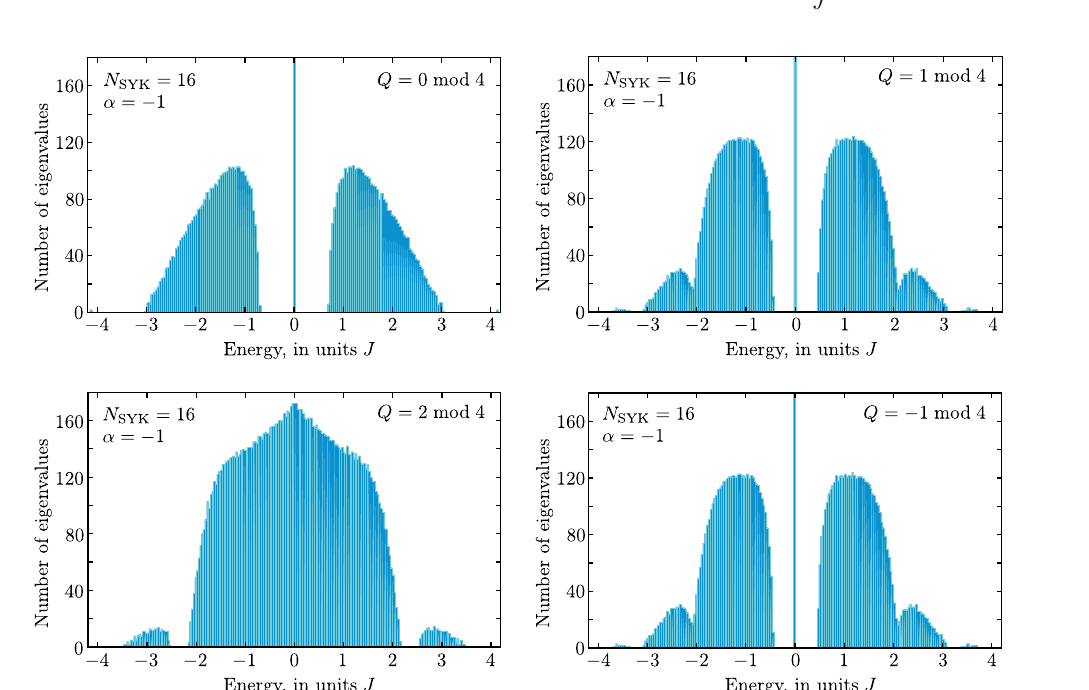
16 and α ¼ − 1 separated into four Z 4 SYK ¼